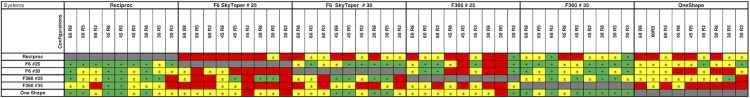
Overview of the significant differences between the systems in the different canal configurations.Green fields indicate a significant (p<0.05) better centering ratio of the file system in lines compared to the file in the specified canal configuration in the corresponding column. Red fields indicate significant (p<0.05) lower centering ratios and yellow fields indicate no significant difference.